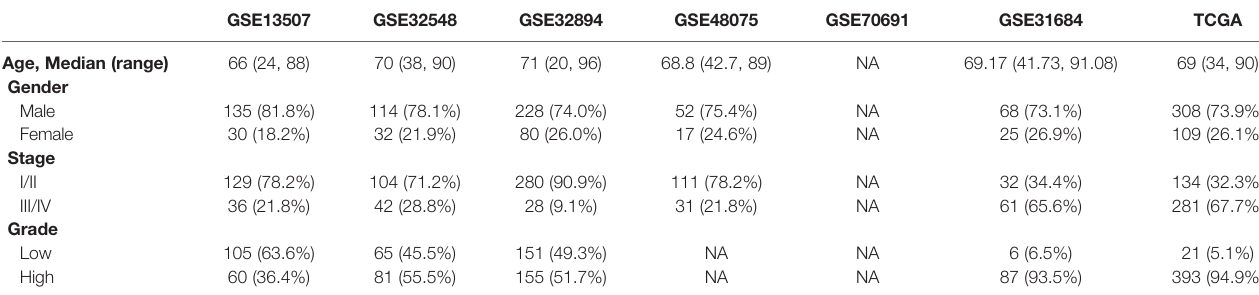
TABLE 1 | Clinical characteristics of bladder cancer